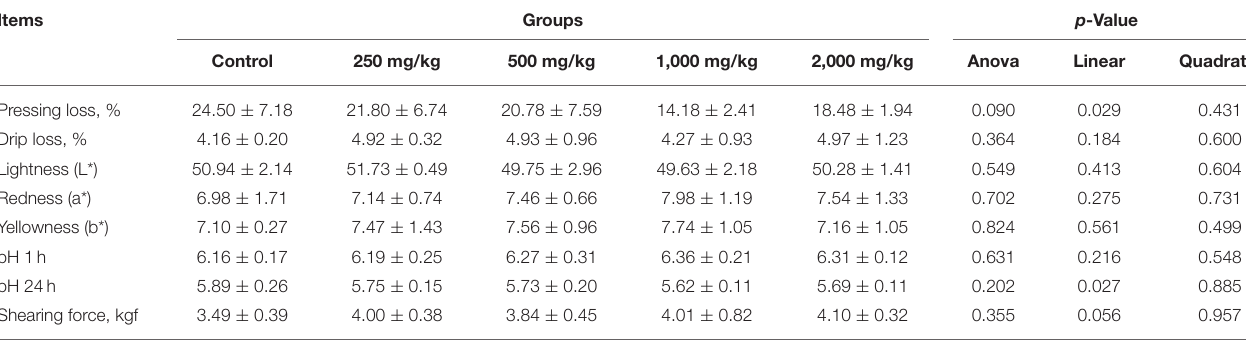
TABLE 4 | Effect of dietary Galla chinensis extract (GCE) supplementation at different levels on meat quality of broilers. Items Groups p -Value